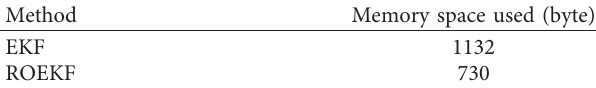
Table 3: Comparison of memory